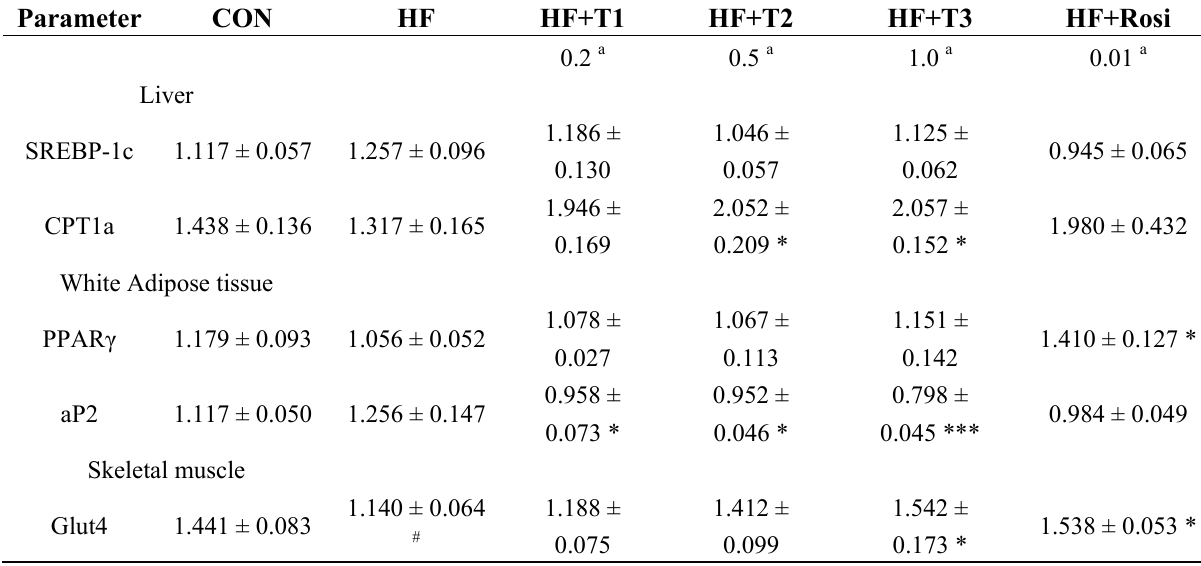
Table 2. Effects of cell suspension culture of Eriobotrya japonica on semiquantative RT- PCR analysis for mRNA expression in liver and white adipose tissue in high-fat-fed